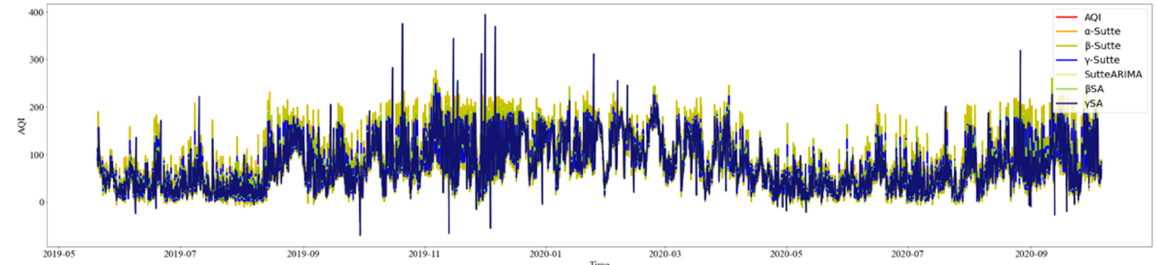
Figure 5. Two ‐ year trend chart of the time series model and ensemble model in the Vientiane area .